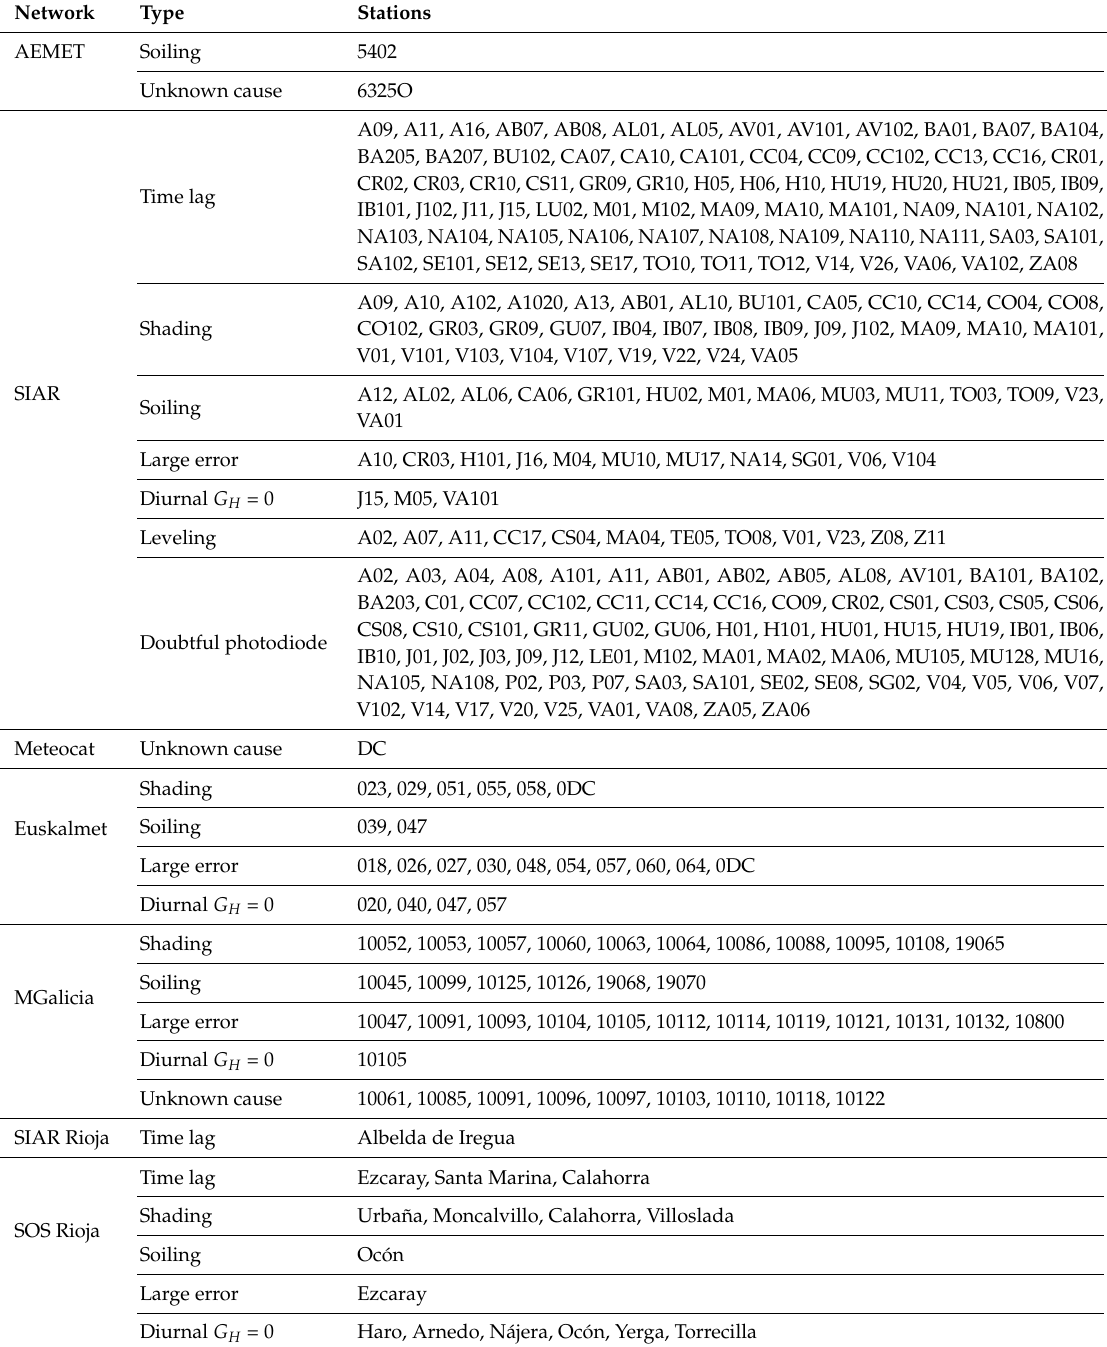
Table 2. List of weather stations flagged by the BQC